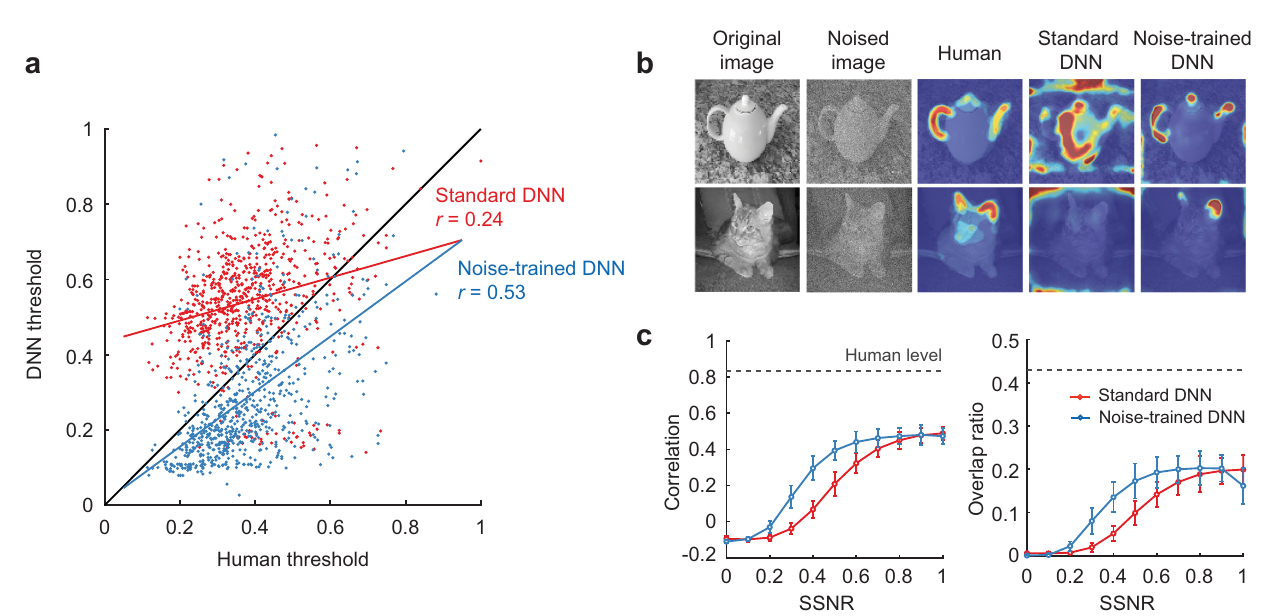
Fig 5. Noise-trained VGG-19 predicts human recognition thresholds. (a) Scatter plot comparing SSNR thresholds of human observers with the thresholds of standard VGG-19 (red) and noise-trained VGG-19 (blue). Each data point depicts the SSNR threshold for an individual object image. (b) Examples of diagnostic object features from human observers, standard VGG-19, and noise-trained VGG-19. The mean SSNR level at which human observers correctly recognized the objects is indicated. Teapot image by Frank Tong . “Red Tabby Cat With Brown Eyes” by Plutonix is licensed under CC BY SA 3.0; the cat image was converted to grayscale with Gaussian noise added. (c) Correlational similarity and overlap ratio of the spatial profile of diagnostic features reported by human observers and those measured in DNNs across a range of SSNR levels. Gray dashed lines indicate ceiling-level performance based on human-to-human correspondence. Confidence intervals (95%) for human-to-human correspondence were extremely small (less than ± 0.001) and therefore are not plotted. Data are available at https://osf.io/bxr2v/. DNN, deep neural network; SSNR, signal-to-signal-plus-noise